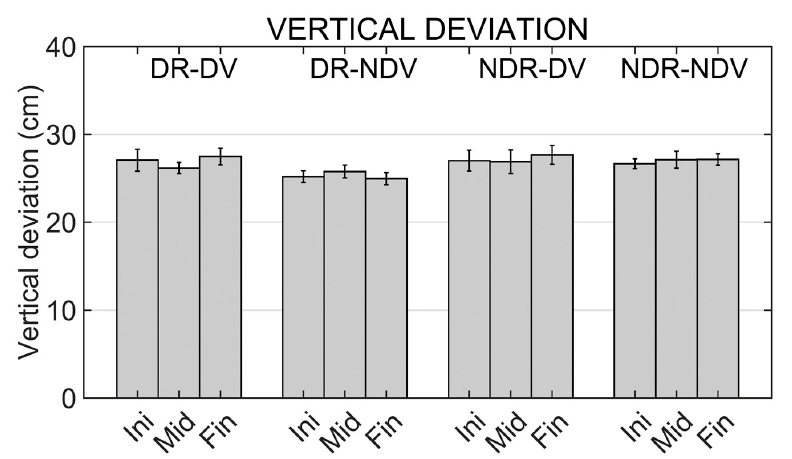
Figure 9. Trajectory maximum vertical deviation in the different experimental conditions (DR_DV, DR_NDV, NDR_DV and NDR_NDV) and in the different moments of the training (Initial, Middle and Final moments). Mean values and standard errors of the mean are shown.